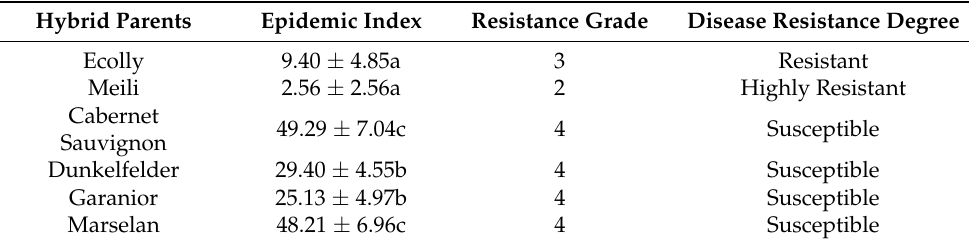
Table 2. Resistance of the hybrid parents against downy